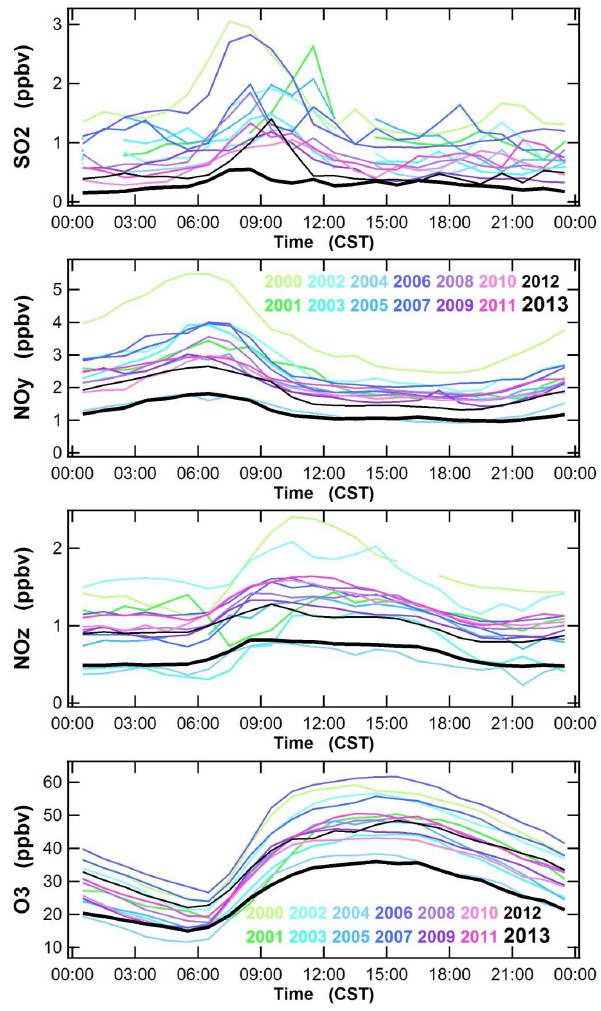
Figure 14. Mean diurnal concentrations of trace gases SO 2 , NO y , NO z , and O 3 at CTR from 1 June through 15 July of each